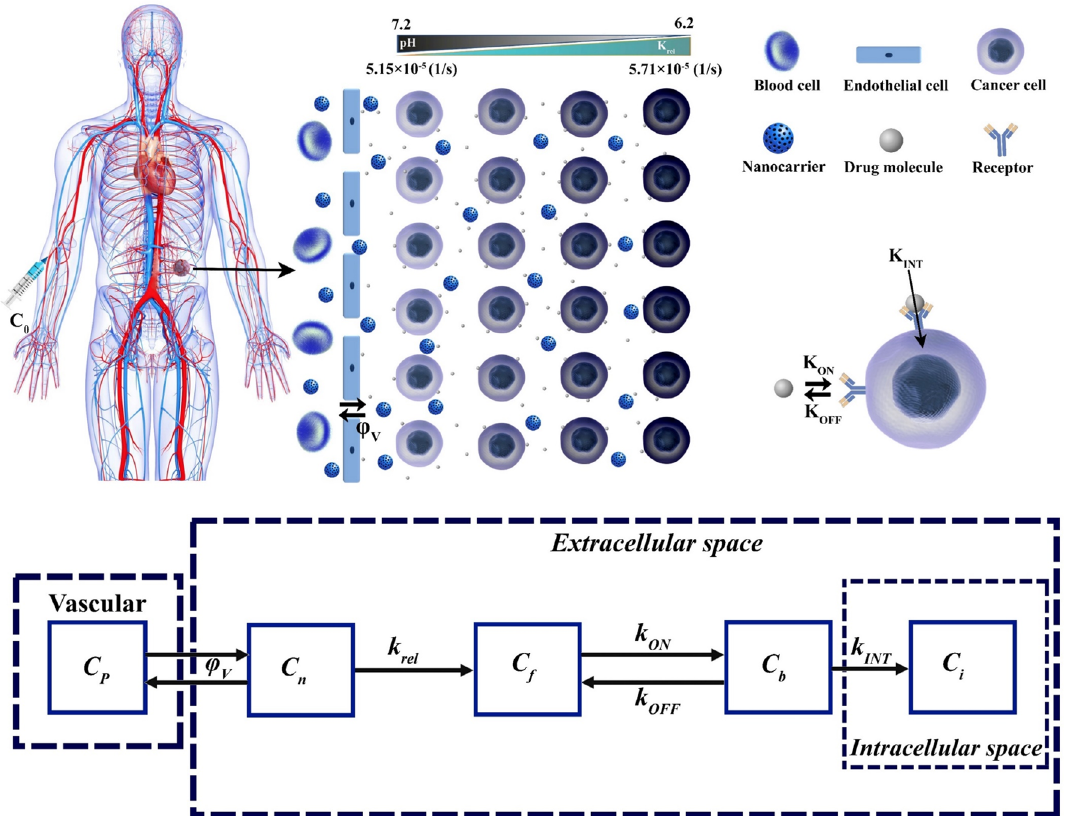
Figure 5. A schematic of drug transport in the vascular, interstitium, and intracellular spaces along with its compartmental representation. ( C 0 : Initial concentration , C p : Vascular concentration , C n : Nanocarrier concentration, C f : Free drug concentration, C b : Bound drug concentration, C i : Intracellular concentration, k rel : Constant of the drug release , k ON : Rate of association of drug with receptors of the cell-surface, k OFF : Rate of disassociation of drug with receptors of the cell-surface, k INT : Constant of cellular uptake, ϕ V : Rate of drug transport per unit volume through the microvessels into the interstitium).